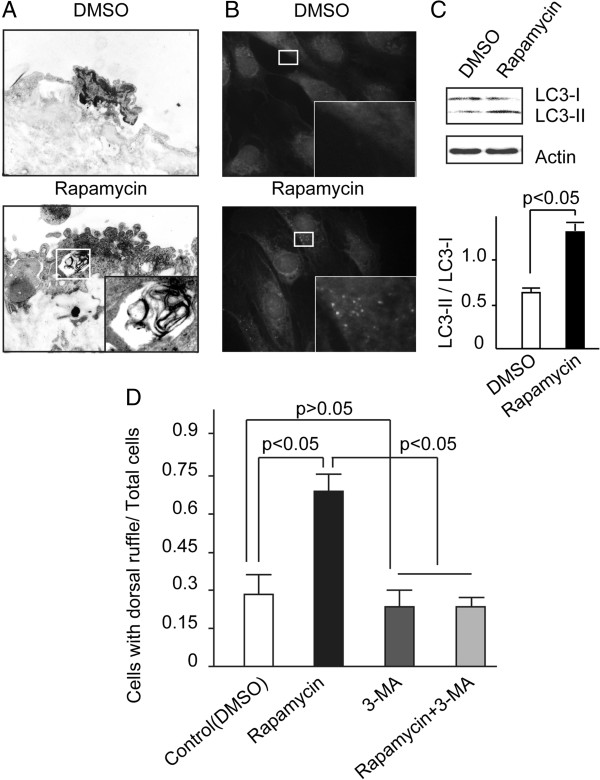
The membrane remodeling was induced by autophagy. (A) Transmission electron microscope analysis exhibited the induction of autophagy in the venous endothelium. Enlarged square showed the autophagosome (TEM × 10, 000). (B, C) HUVECs were treated with the indicated reagents, followed by fixation and detection by immunofluorescence (B) and western blot (C) with anti-LC3-II antibody. The representative images indicated the dot-like structure of autophagosomes in the cells (B) and the expression of LC3-II in cells (C). Means ± SD are given and were obtained from 4 independent experiments. (D), HUVECs were treated with the indicated reagents, and the formation of dorsal ruffle was analyzed. The data exhibited that rapamycin induced dorsal ruffling. While 3-MA can suppress the formation of dorsal ruffle which was promoted by rapamycin. Means ± SD are given and were obtained from 3 independent experiments.